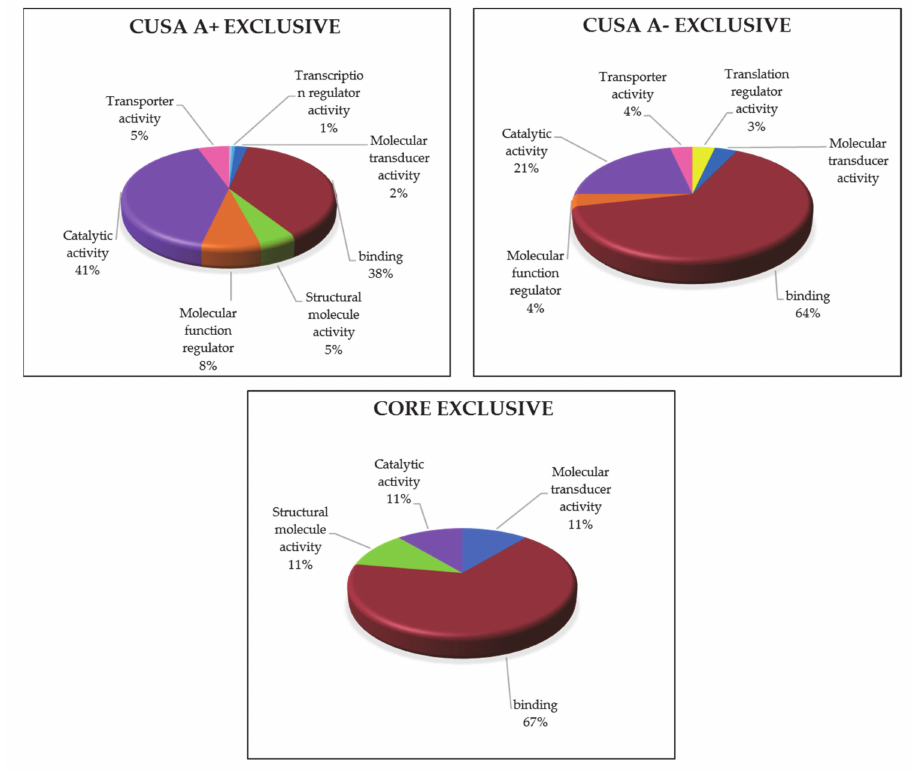
Figure 8. GO molecular function classification of the exclusive protein elements of each zone. The protein class categorization was very different among the three zones. CUSA CORE exclusive proteins consist in only four protein classes, also according to their low number, i.e., nine protein elements. One interesting finding is that in CUSA A- there is a higher representation of defense/immunity proteins, supporting the idea that the overall consid- ered negative zone contains functions necessary to avoid pathological invasion. Another consideration is concerning hydrolase being present in CUSA A+ (18%), while only 4% present in CUSA